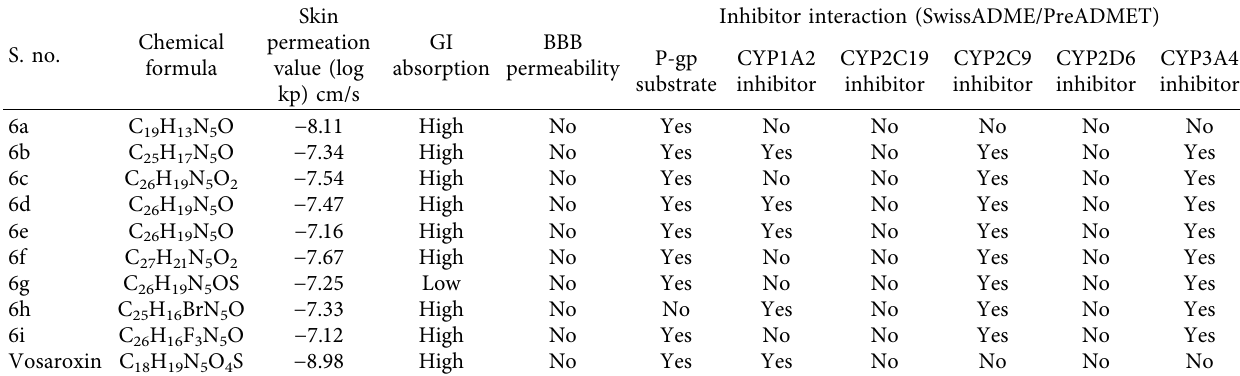
Table 7: ADME predictions of compounds 6a-i, computed by SwissADME and PreADMET. S. no.